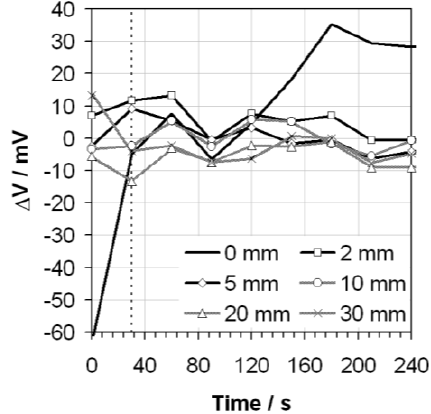
Figure 4. Differential voltage (  V) exhibited by the glass electrode as a function of time when measuring ethanol containing 0.02 g/g of water using the ASTM D6423 method, for a variety of vortex depths (as indicated in the legend), relative to that measured for a vortex depth of 7 mm. The ASTM D6423 specified measurement time is also indicated (vertical dotted